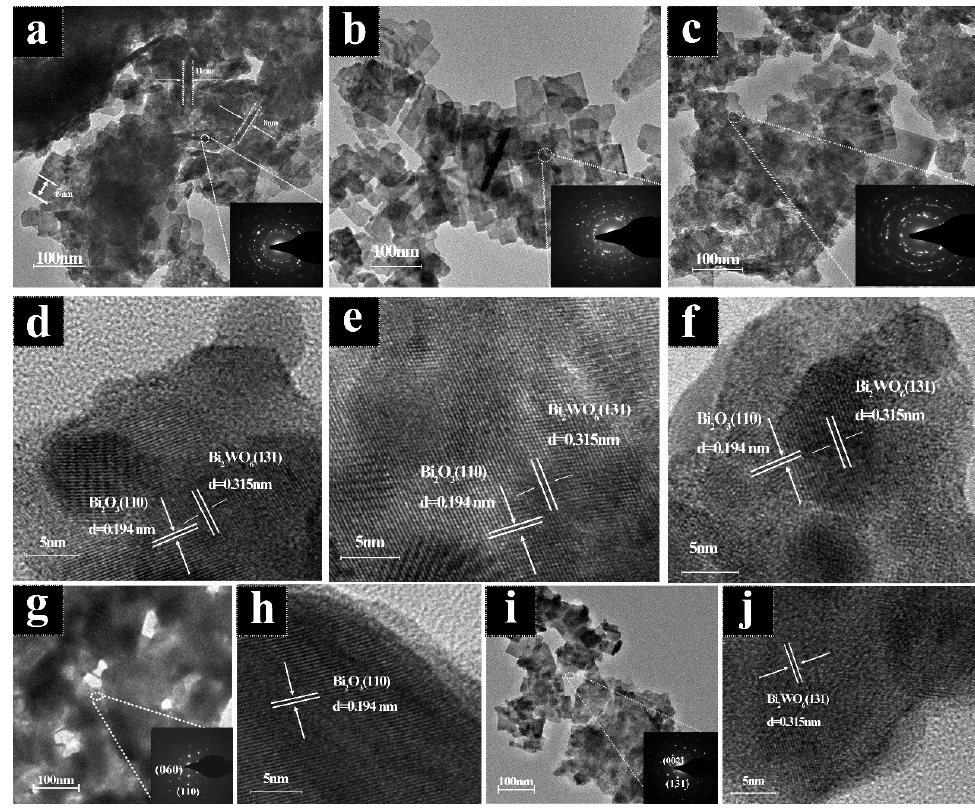
Figure 3. TEM images of 1:6 Bi 2 WO 6 /Bi 2 O 3 ( a ), 1:8 Bi 2 WO 6 /Bi 2 O 3 ( b ), and 1:10 Bi 2 WO 6 /Bi 2 O 3 ( c ); HRTEM images of 1:6 Bi 2 WO 6 /Bi 2 O 3 ( d ), 1:8 Bi 2 WO 6 /Bi 2 O 3 ( e ), and 1:10 Bi 2 WO 6 /Bi 2 O 3 ( f ); TEM and HRTEM images of SSBT Bi 2 O 3 ( g , h ); TEM and HRTEM images of Bi 2 WO 6 ( i , j ).